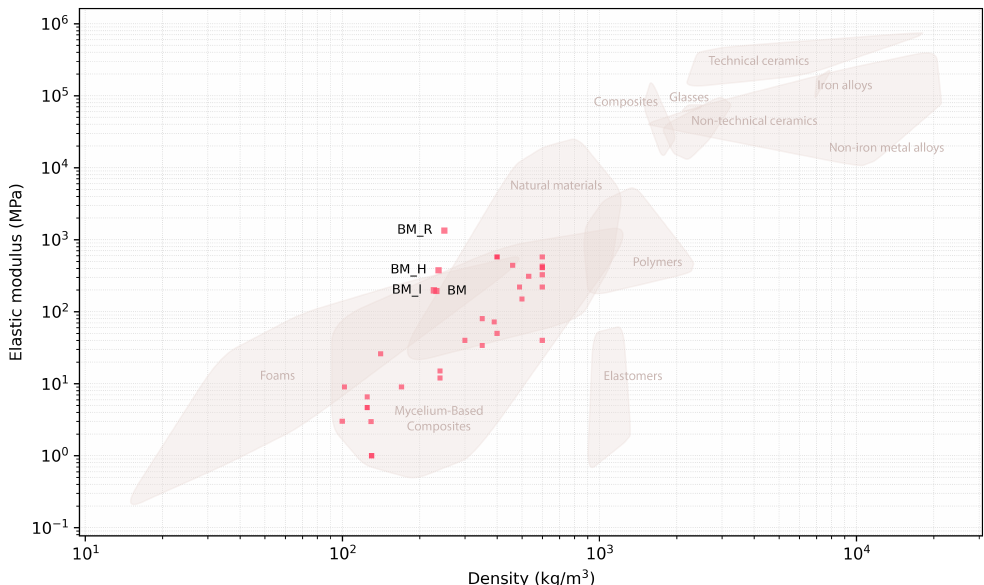
Figure 5. Flexural modulus results as a function of density. Labelled data points: results from this study; unlabelled data points: reports from the state-of-the-art.